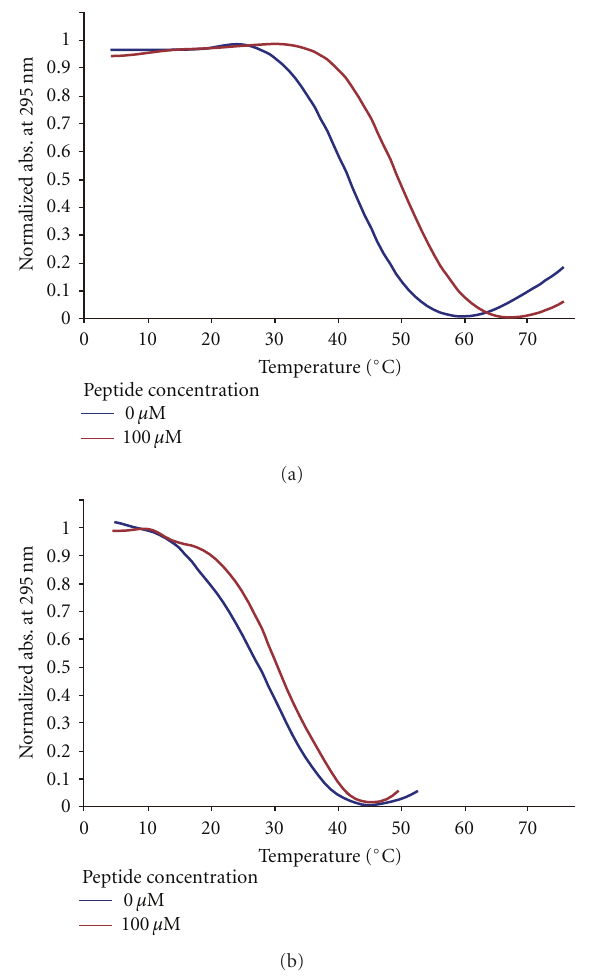
Figure 6: Normalized UV melting curves for (a) MYC and (b) FGF with/without 100 μ M peptide no.